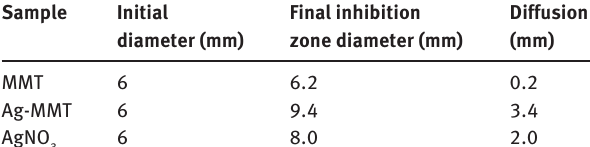
Figure 11 The minimum inhibitory concentration against S. aureus of Ag-MMT and AgNO 3